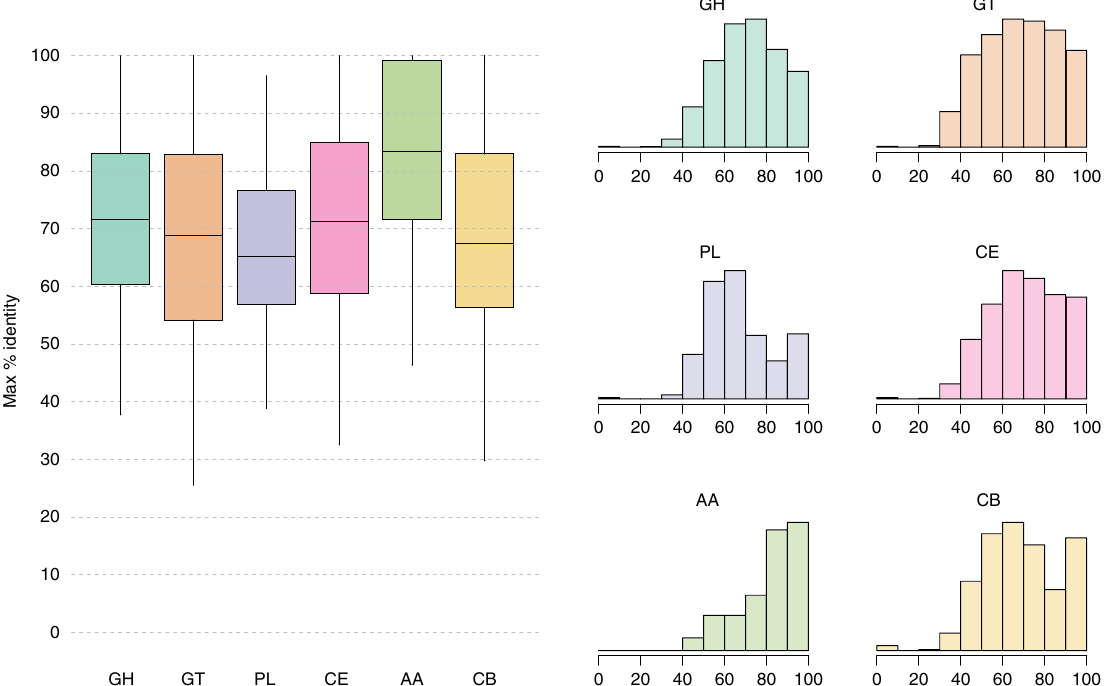
Fig. 3 Distribution of the maximum percentage identity of the RUG proteins against fi ve public databases for six classes of carbohydrate-active enzymes. GH glycoside hydrolase, GT glycosyl transferase, PL polysaccharide lyases, CE carbohydrate esterases, AA auxiliary activities, CB carbohydrate